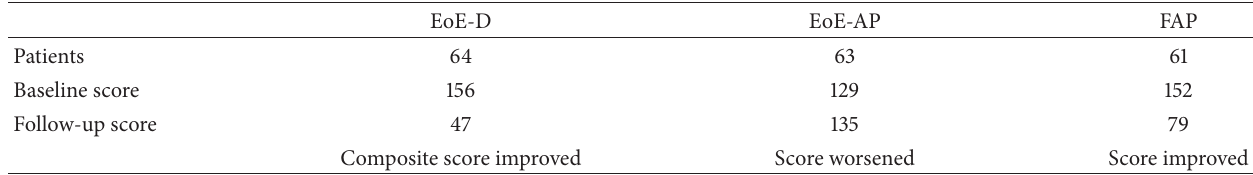
Table 4: Composite symptom score ∗ change, baseline versus follow-up. EoE-D EoE-AP